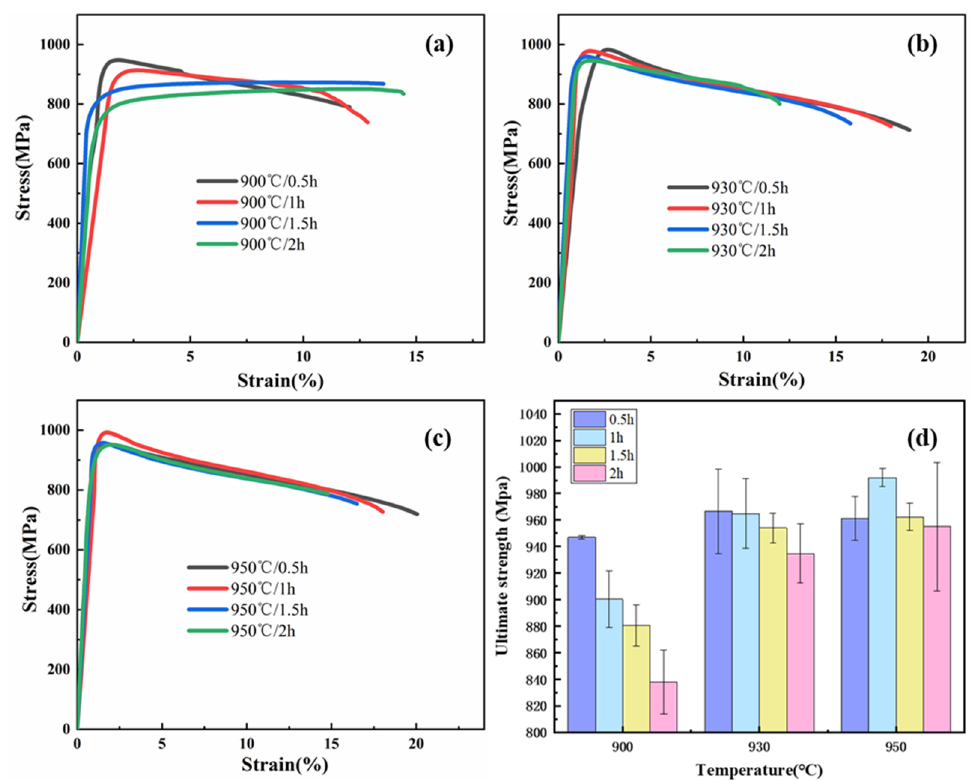
Figure 9. The effect of B2 slow cooling to aging treatment to ambient tensile curve for Ti-22Al-25Nb alloy: ( a ) 900 °C/0–2 h, ( b ) 930 °C/0–2 h, ( c ) 950 °C/0–2 h, ( d ) the ultimate strength (UTS) of the alloy at different temperatures.